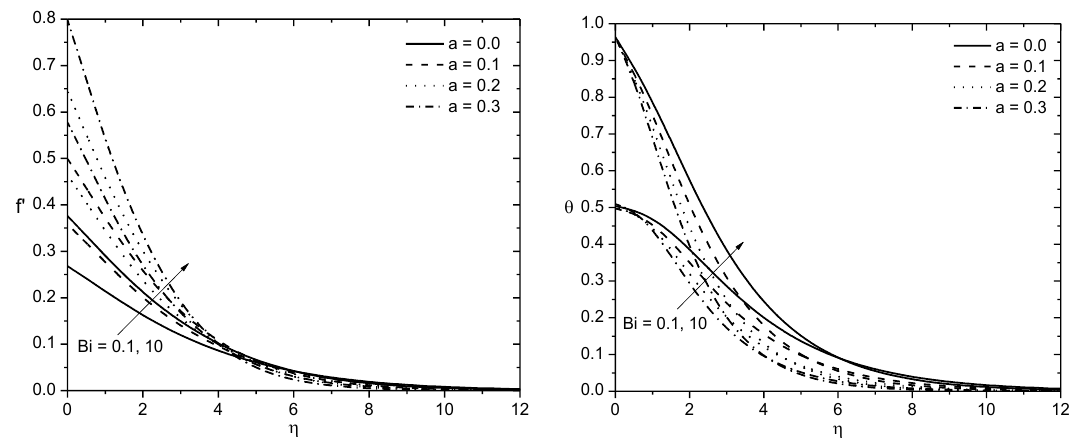
Figure 4. Effects of Gr * and A on the solid volume fraction